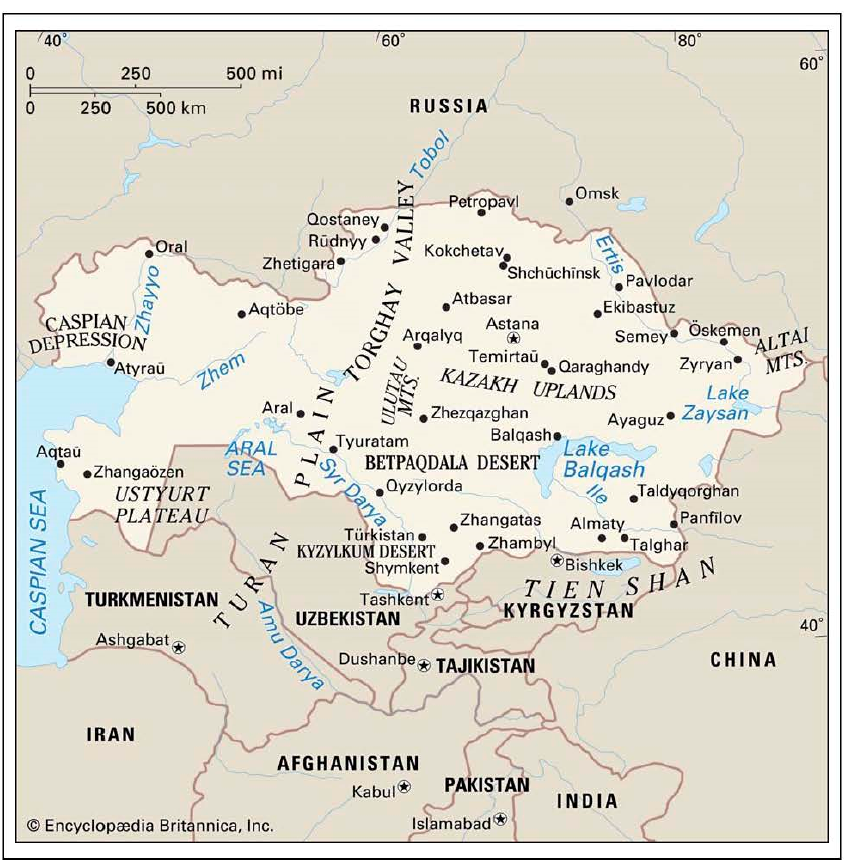
Figure 1. The locations of the major cities of Kazakhstan (map) [68].